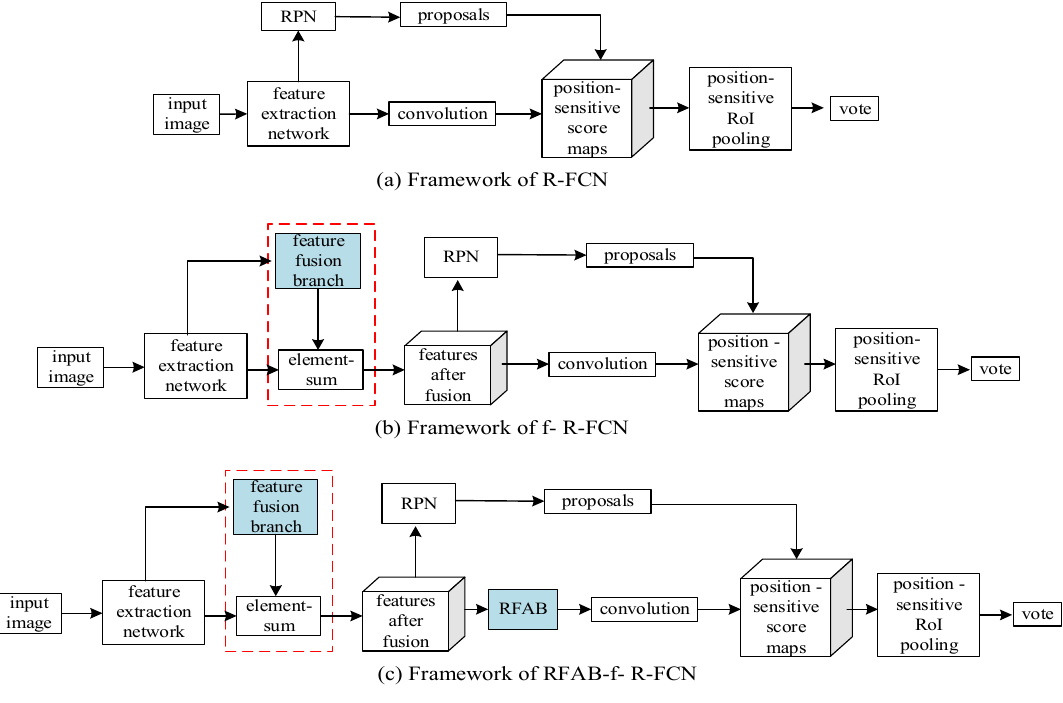
Figure 1. The framework of region-based fully convolutional networks (R-FCN) and small-scale face detection based on R-FCN. detection based on